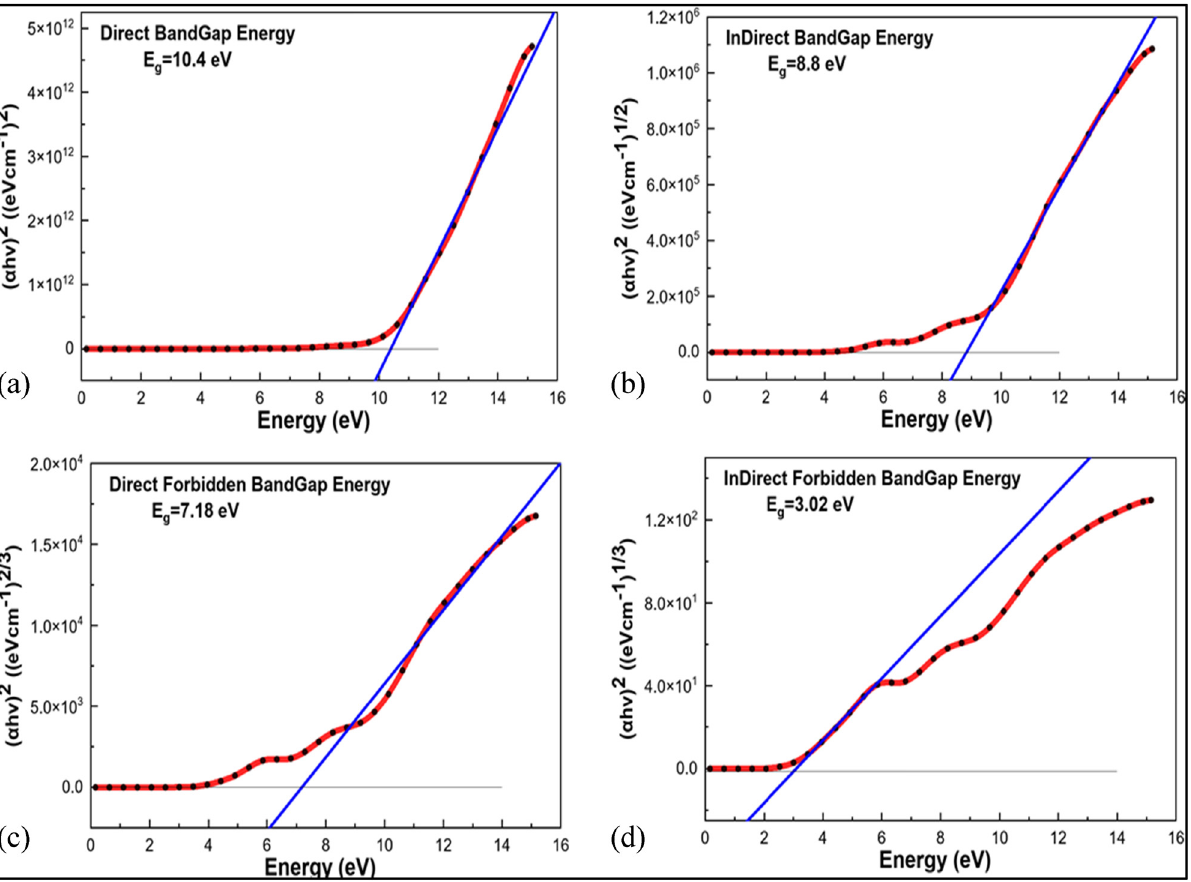
Figure 8: A schematic Tauc plot demonstrating the band gap for nylon 66 using several transition modes: ( a ) direct bandgap, ( b ) indirect bandgap, ( c ) direct forbidden bandgap, and ( d ) indirect forbidden